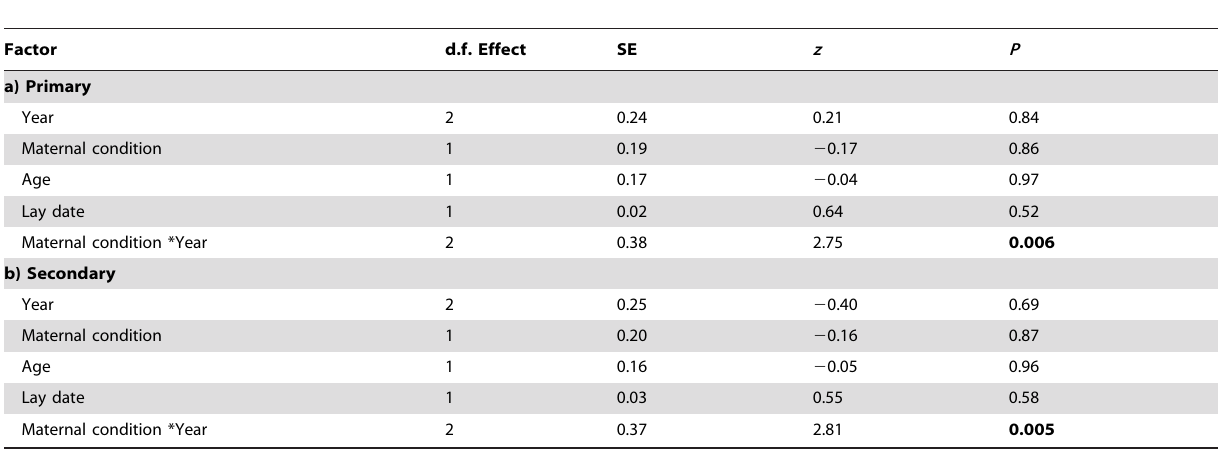
Table 1. The results of GLMs investigating whether maternal body condition influenced a) primary ( n =89) and b) secondary ( n =88) brood sex